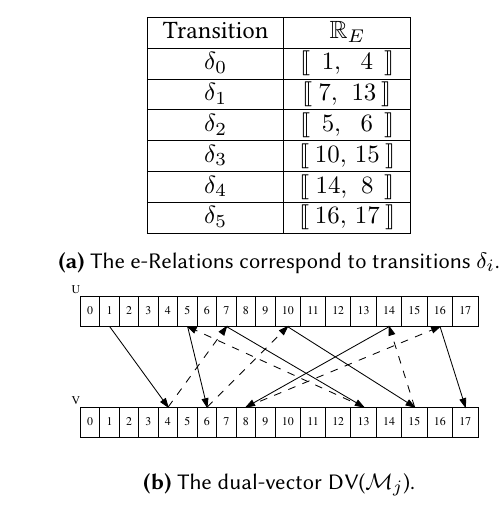
Figure 6. The time spent on updating the model two transitions are R i E